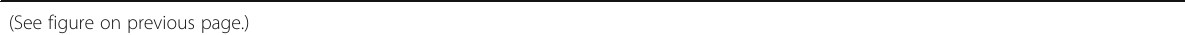
Fecal microbiota from SLE mice induce pathological changes of gene expression in the colon of GF mice We determined the effect of FMT from different mice on the differential expression of genes (DEGs) by ana- lysis of the colon transcriptomes in the different groups.